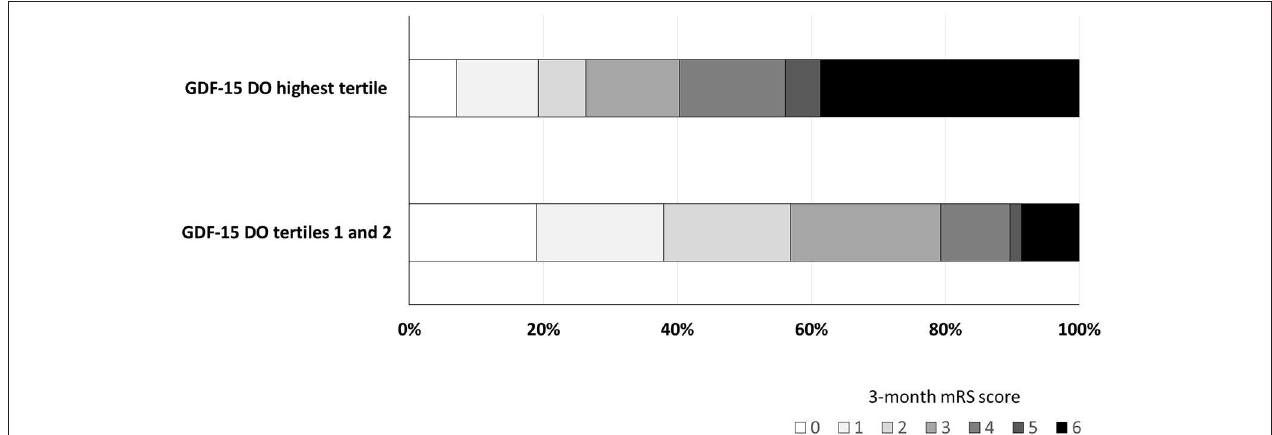
FIGURE 4 | Distribution of mRS scores at 3 months according to D0 GDF-15 tertiles.